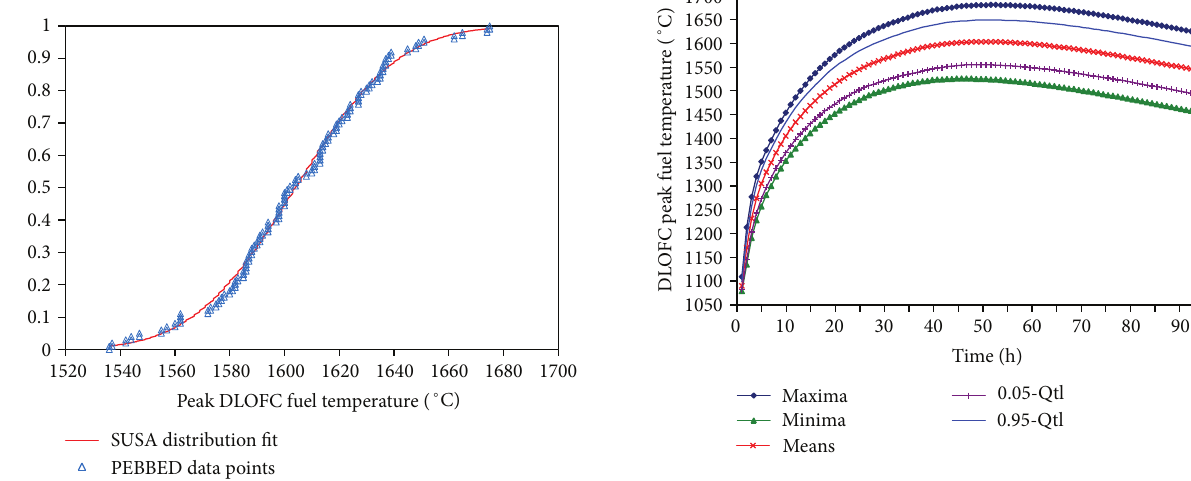
F 13: Time dependent minima, maxima, mean and 5/95 percentiles for the 200 LHS Normal set maximum fuel